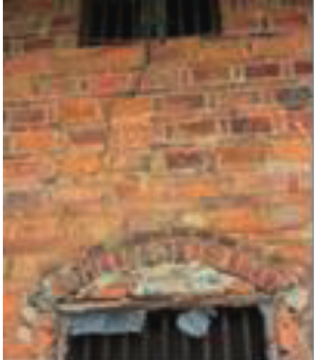
Figure 3: Crack in the wall between the windows.